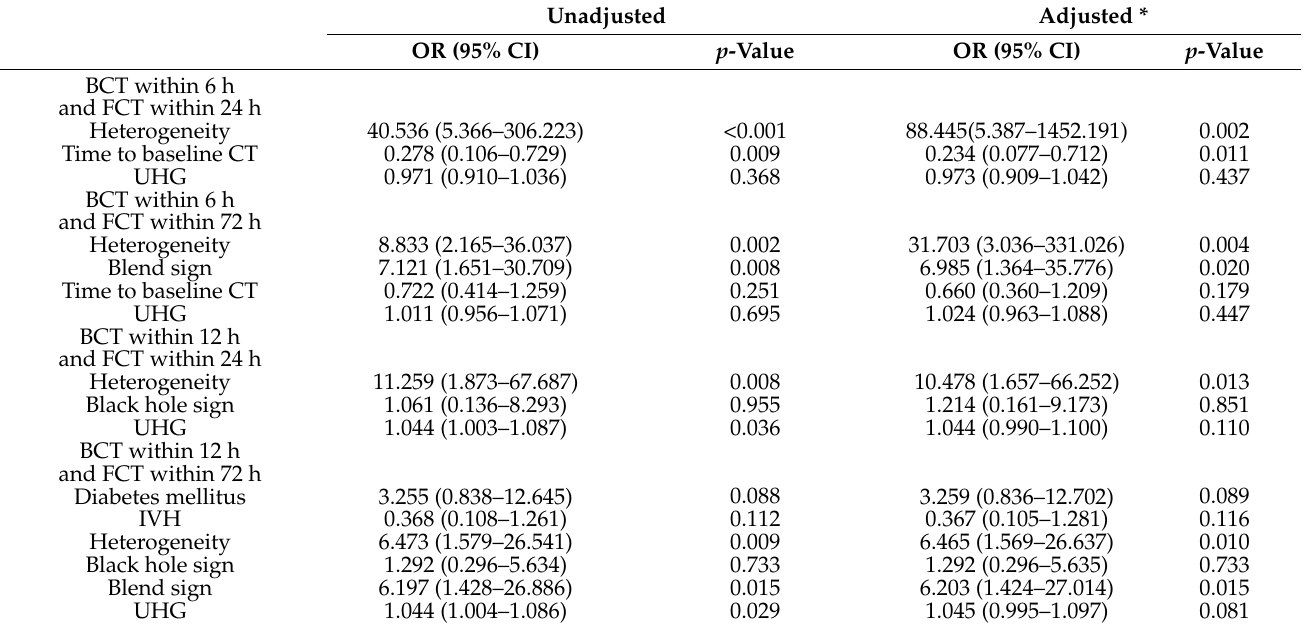
Table 4. Multivariate analysis of the predictors for hematoma expansion in different types.